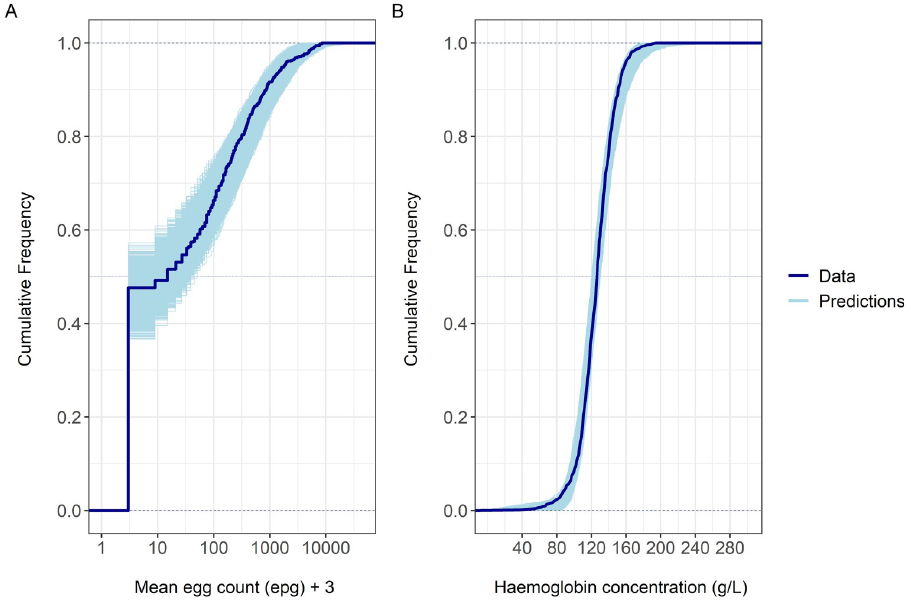
Fig 3. Comparison of observed data and model prediction. (A) Full posterior predictive checks for the mean egg counts. Mean egg count data are shifted of +3 epg (i.e. half of the detection limit) to display the zero counts on the logarithmic-scaled axes. (B) Full posterior predictive checks for haemoglobin concentrations. Dark lines represent the corresponding distribution observed in the Ugandan population. Both marginal predictive distributions are displayed through the cumulative distribution function of the predictions based on 20,000 replications (light lines) and compared with observed data.